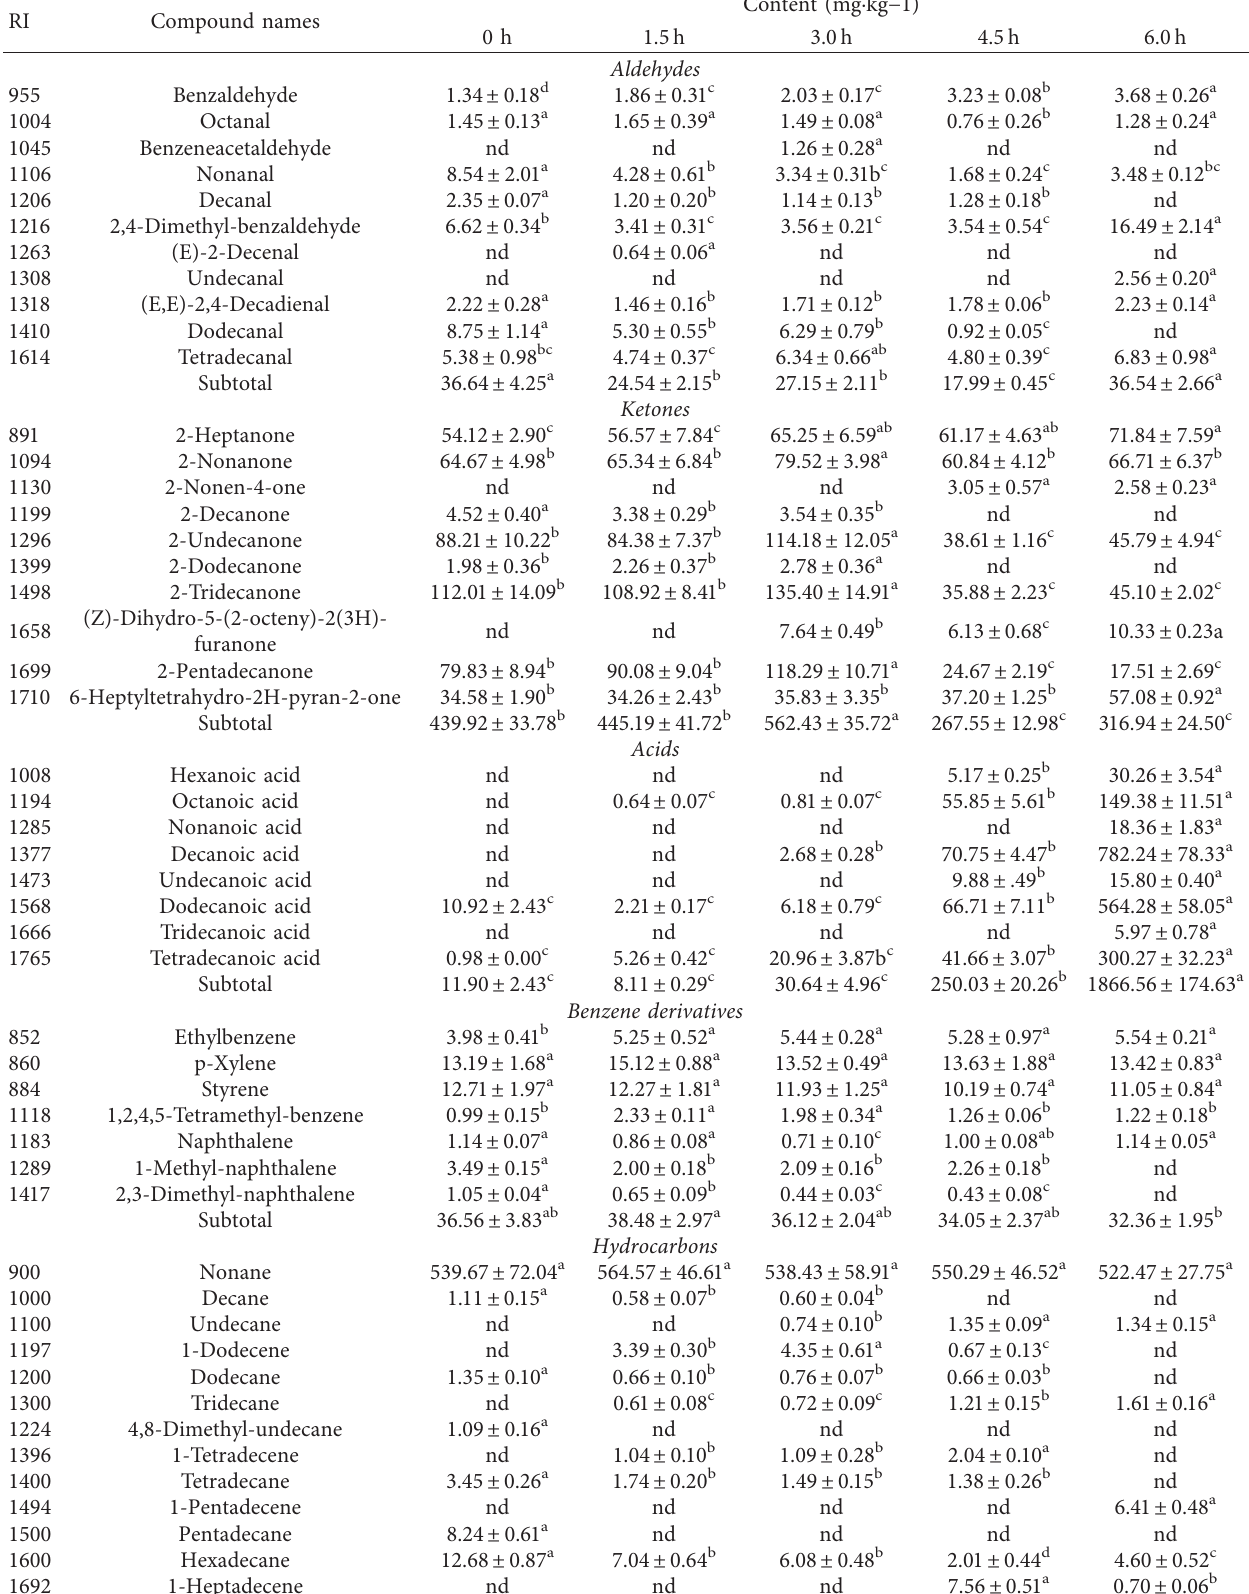
Table 1: Content of volatile compounds in yogurt by S. thermophilus at different fermentation times.